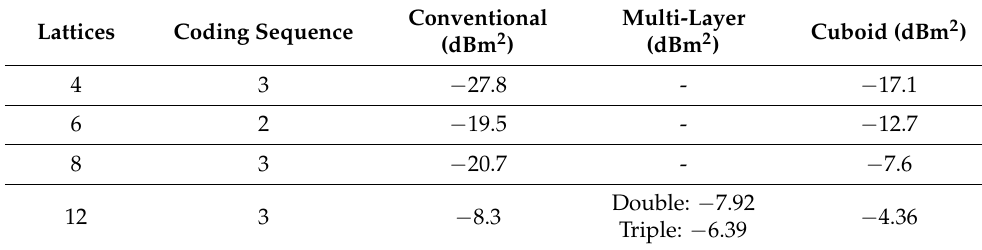
Table 10. Comparison table of bistatic RCS reductions at 8